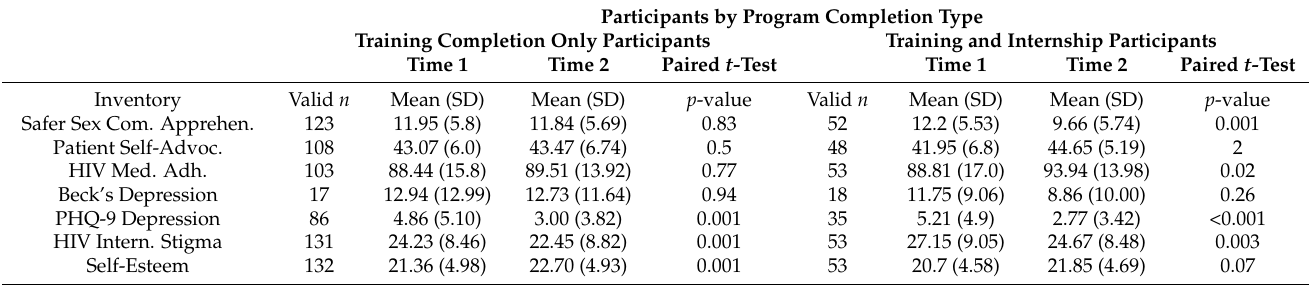
Table 6. Change in psychosocial inventories scores from baseline to training completion, by level of program participation.